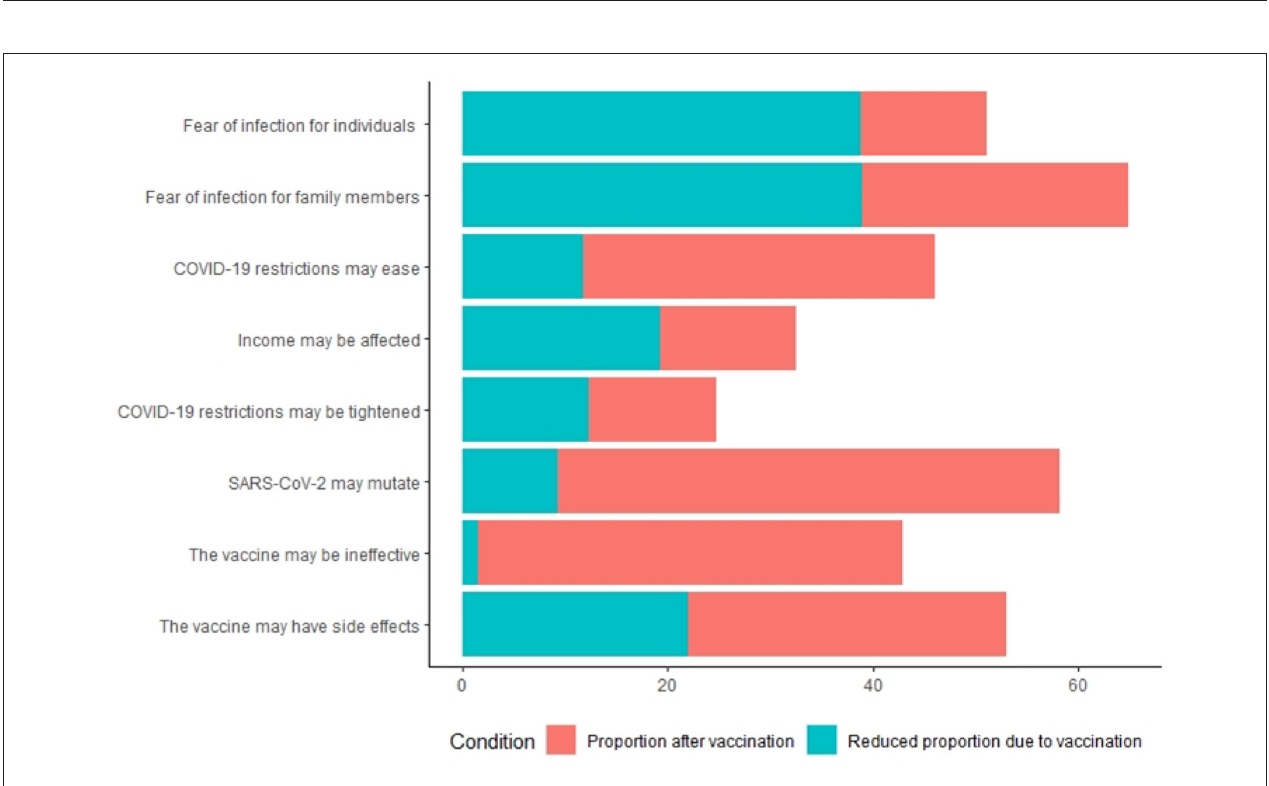
FIGURE 2 | Impact of COVID-19 vaccination status on public concerns.